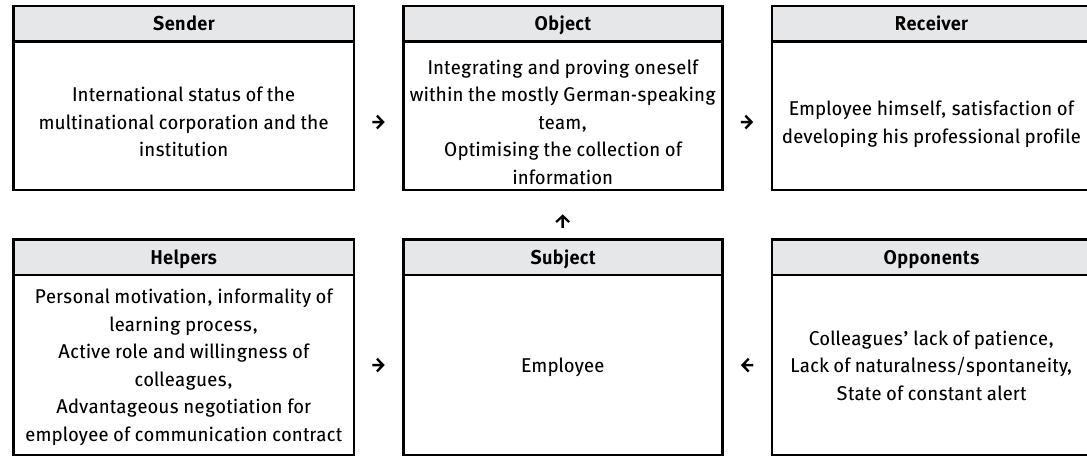
Figure 4. Actantial model 3: